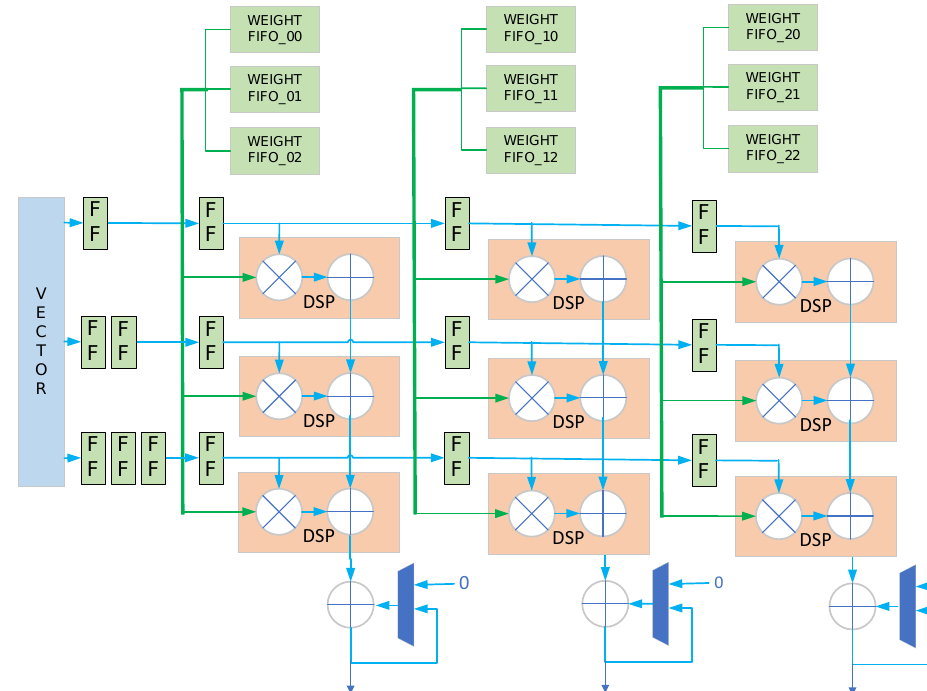
Figure 4. Design of matrix multiplication